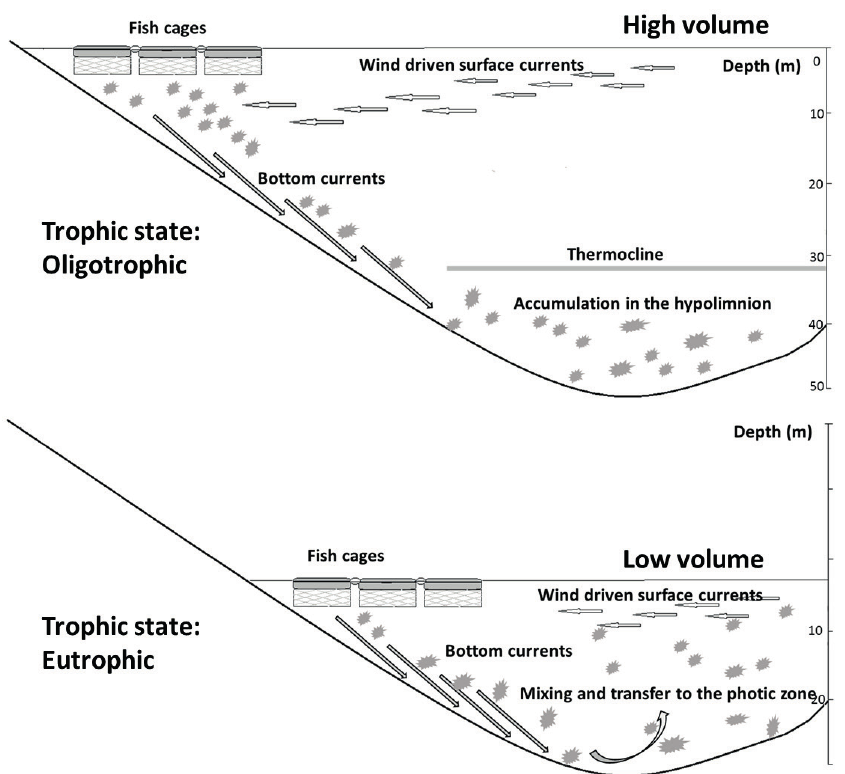
Figure 12 - Limnology and hydrodynamics of the Castanhão reservoir during normal rainfall regime and after an extended drought period showing the processes involved with triggering eutrophication.